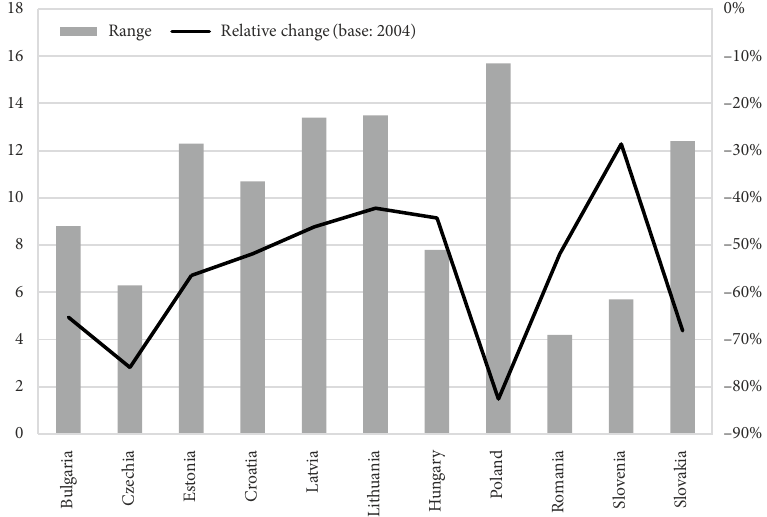
Figure 1. Range and relative change of unemployment rate in CEE countries for years